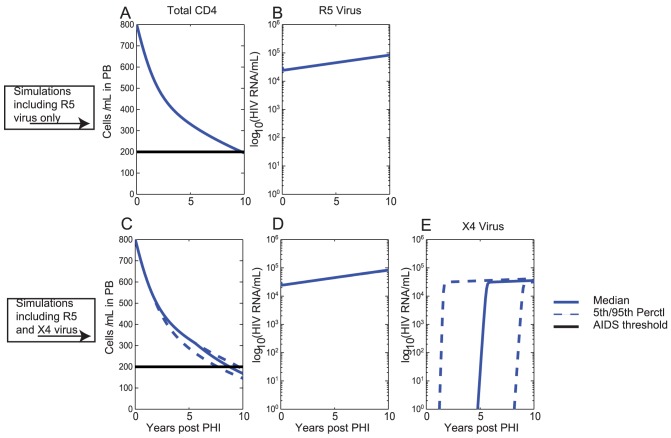
Progression of untreated HIV infection over a 10-year period.Here year 0 denotes the end of primary HIV infection (PHI). Solid lines denote median values, dashed lines denote the 5th and 95th percentile ranges. Also shown is the AIDS threshold of 200 cells/ µL (solid horizontal black line); A) Total CD4+T cell count and B) R5 Viral Load for a single simulation of untreated infection with R5 virus only (i.e. assuming  throughout the course of infection); C) Total CD4+T cell count, D) R5 Viral Load and E) ×4 Viral Load for Monte Carlo simulations (100 trials) of untreated infection assuming initial infection with R5 virus, but now including ×4 virus.